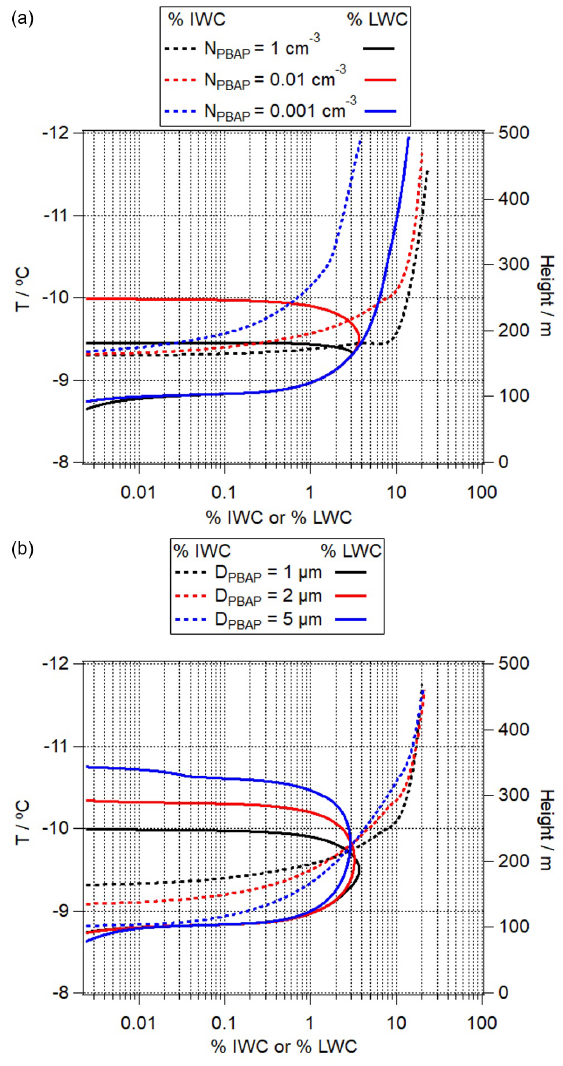
Figure 9. Percentage contribution of ice water content (%IWC, dashed lines) and liquid water content (%LWC, solid lines) to the total adiabatic water content as a function of (a) N PBAP and (b) D PBAP . Details on the simulations can be found in Table